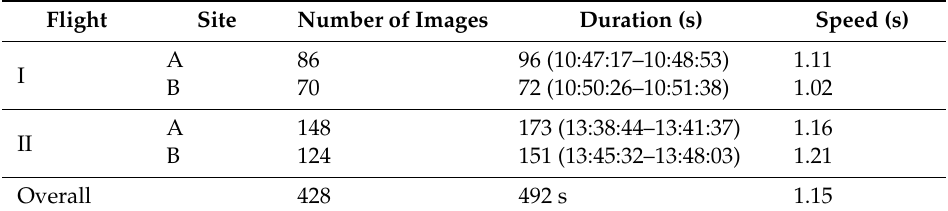
Table 5. The number of the transmitted images and the corresponding durations of the two dedicated flights for testing the time required to transmit the detection results to the Warning Module.